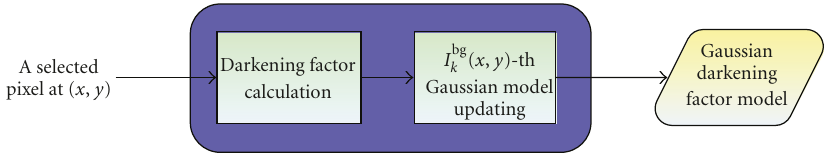
Figure 17: Gaussian darkening factor model updating procedure.